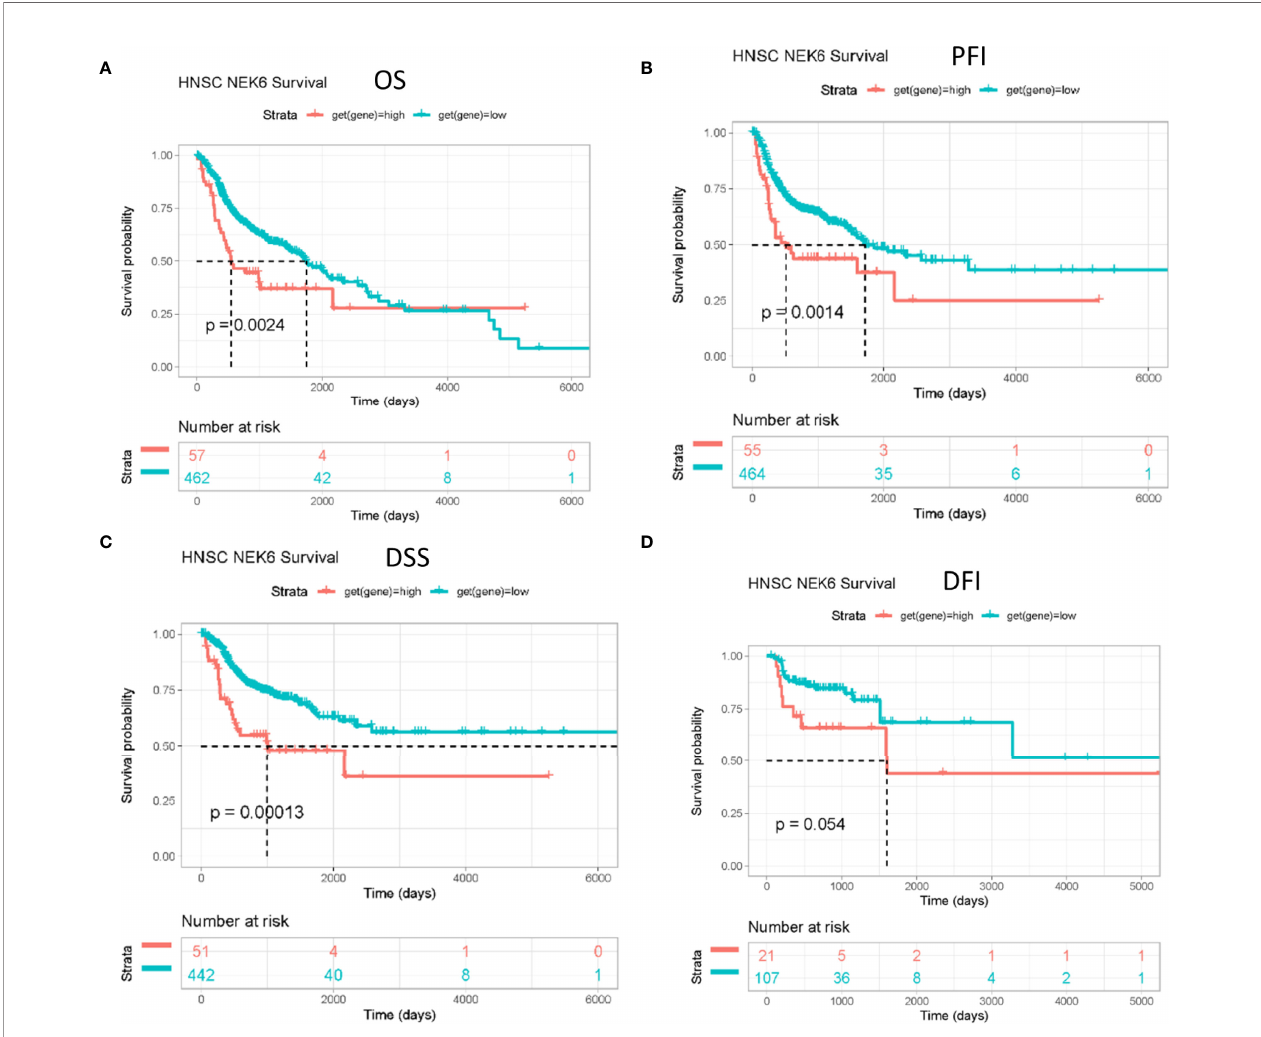
FIGURE 2 | Prognostic value of NEK6 in HNSCC. Survival curves for (A) OS, (B) PFI, (C) DSS, (D) DFI were displayed using a Kaplan-Meier